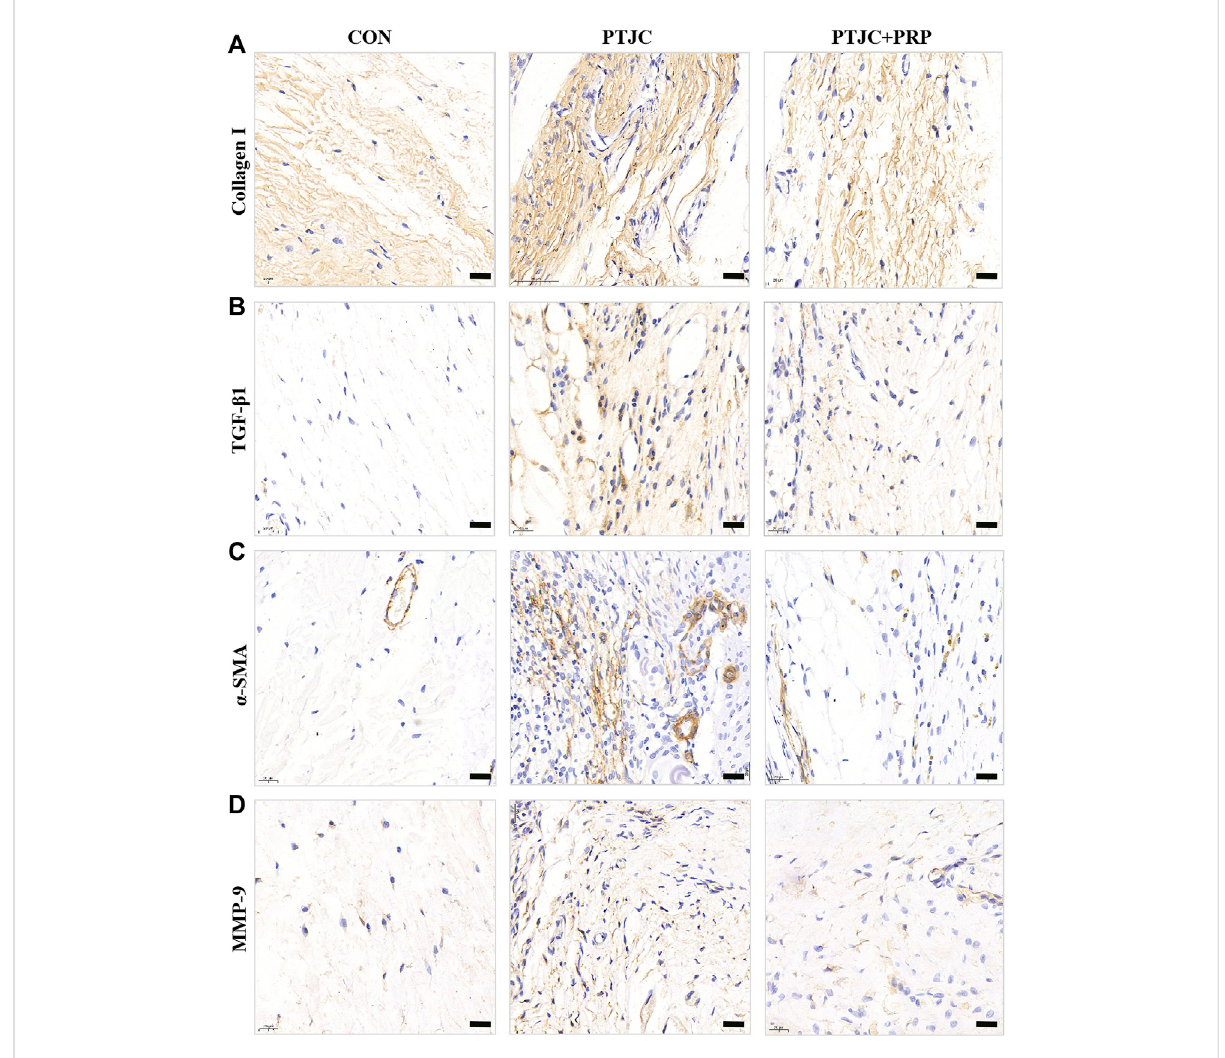
FIGURE 6 Expression of fi brosis-associated proteins in the posterior joint capsule were assessed via immunohistochemical. (A – D) The immunohistochemical staining of COL- Ⅰ (A) , TGF- β 1 (B) , α -SMA (C) , MMP-9 (D) in the posterior joint capsule. Scale bars, 50 μ